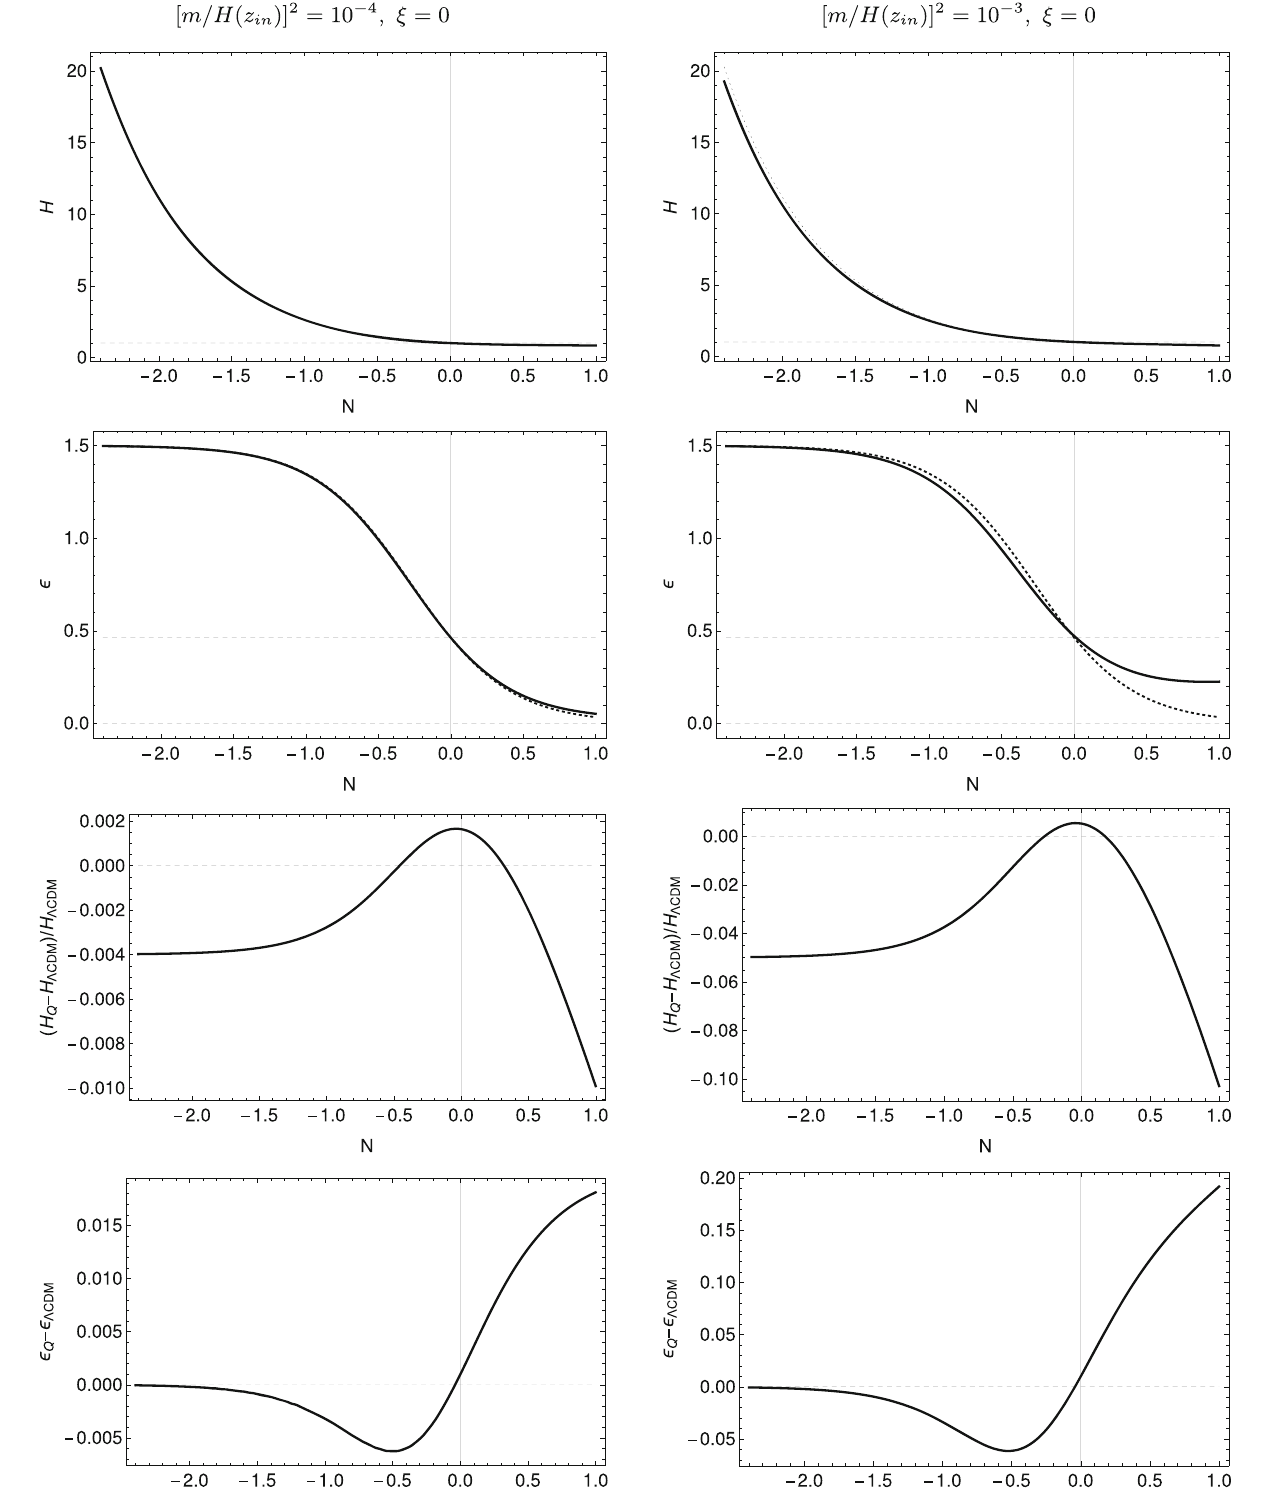
Fig. 2 Quantum backreaction model versus the Λ CDM model. Two columnsrepresenttwodifferentchoicesofparameters ξ and m . Leftcol- umn [ m / H ( z in ) ] 2 = 10 − 4 , ξ = 0. Right column [ m / H ( z in ) ] 2 = 10 − 3 , ξ = 0. The first row shows plots of the Hubble rate, and the second